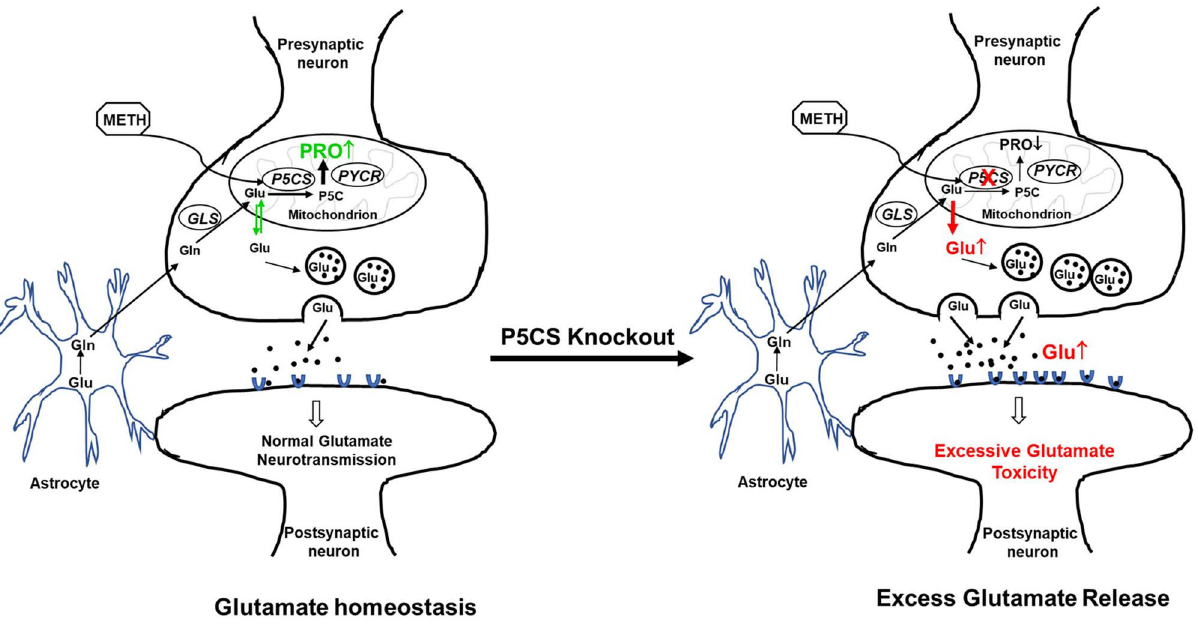
Figure 7. Proposed model demonstrating the key role of P5CS in maintaining glutamate homeostasis during acute METH exposure. The schematic model shows presynaptic and postsynaptic neurons along with astrocytes and highlights the pathways involved in glutamate homeostasis in the brain. The left panel depicts the sequestration of excess glutamate in the neuron for proline biosynthesis during acute METH exposure. Specifically, METH-induced enhancement of P5CS expression is associated with utilization of glutamate for proline synthesis, thus maintaining glutamate homeostasis. Whereas, the right panel describes that depletion of P5CS blocks the proline synthetic arm from glutamate and abrogates glutamate sequestration for proline biosynthesis. This metabolic disruption results in an increased levels of glutamate that could be detrimental for the